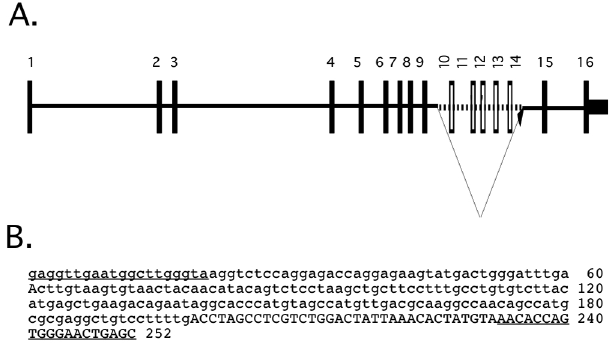
Figure 4. Sequence of Ndrg1 allele from stretcher mice. A . Genomic organization of Ndrg1 gene. Exons are represented by filled boxes. The extent of deletion between introns 9 and 14 is indicated; the deleted sequence is indicated by the dotted line and empty boxes. Sequence is shown reversed in comparison to chromosomal orientation. B . Sequence flanking the deletion point. Lower case: sequence from intron 9; upper case: intron 14 sequence; underline: sites for primers to amplify deletion